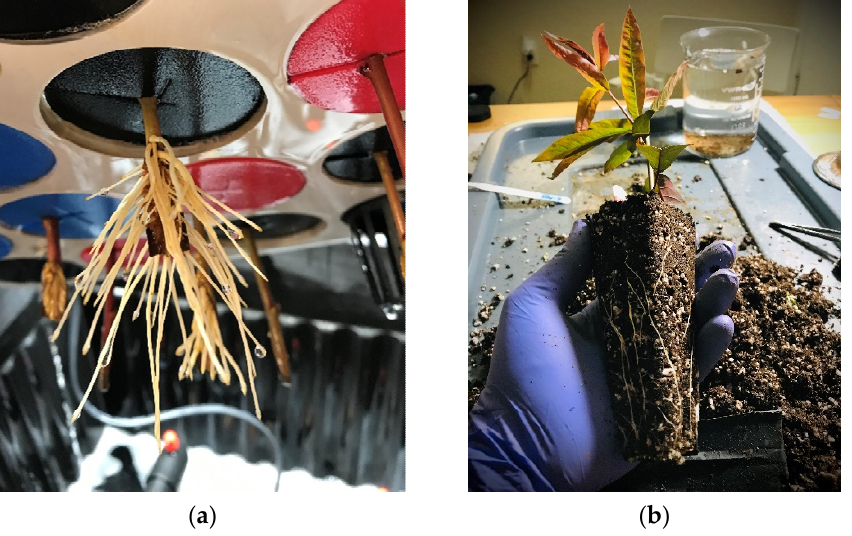
Figure 7. Samples of softwood cuttings from the peach backcross progenies rooted in the aeroponic systems ( a ) and in the germination trays ( b ).